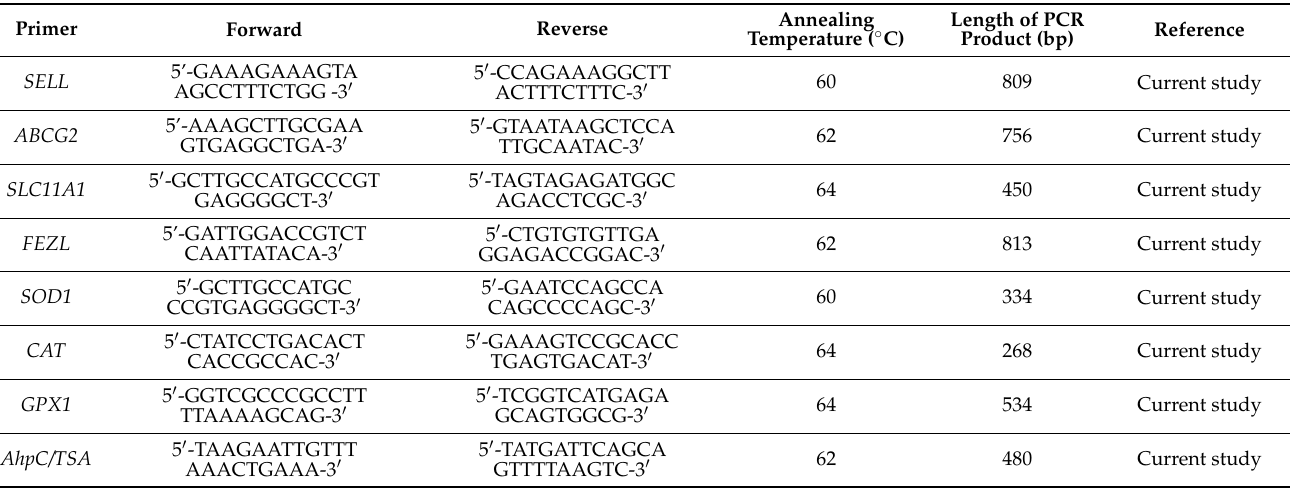
Table 1. Forward and reverse primer sequence, length of PCR product and annealing temperature for genes used in PCR-DNA